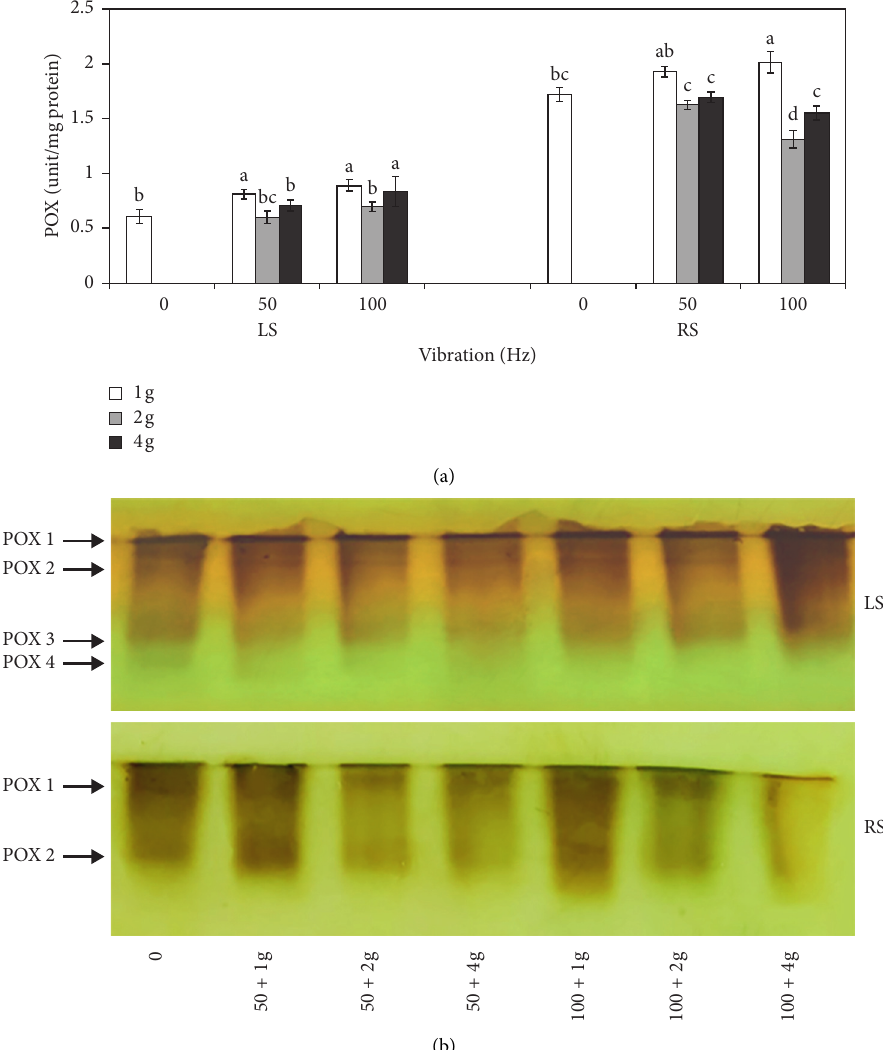
Figure 5: Effect of different sinusoidal vibrations (0, 50, and 100Hz) and accelerations (1, 2, and 4g) on the activities (a) and isoform patterns (b) of POX enzyme in A. gilanica calli. Bars indicate mean ± SE ( n � 4) in each group. Different letters indicate significant differences at P < 0 . 05